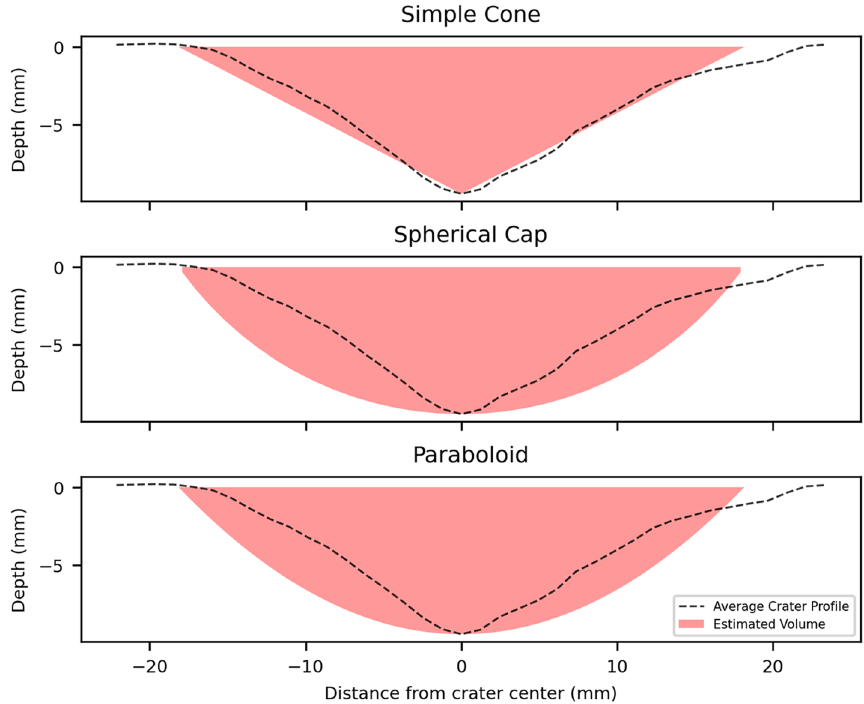
Figure 5. Average cross section profile of sample SRS_14 and cross section through the simplified crater geometries that use the max depth and D eq .